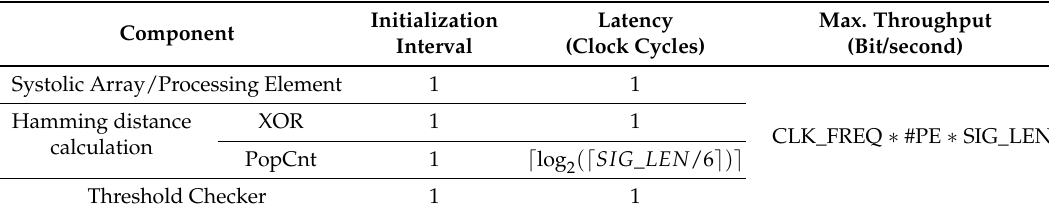
Table 3. Performance characteristics of the individual components of a